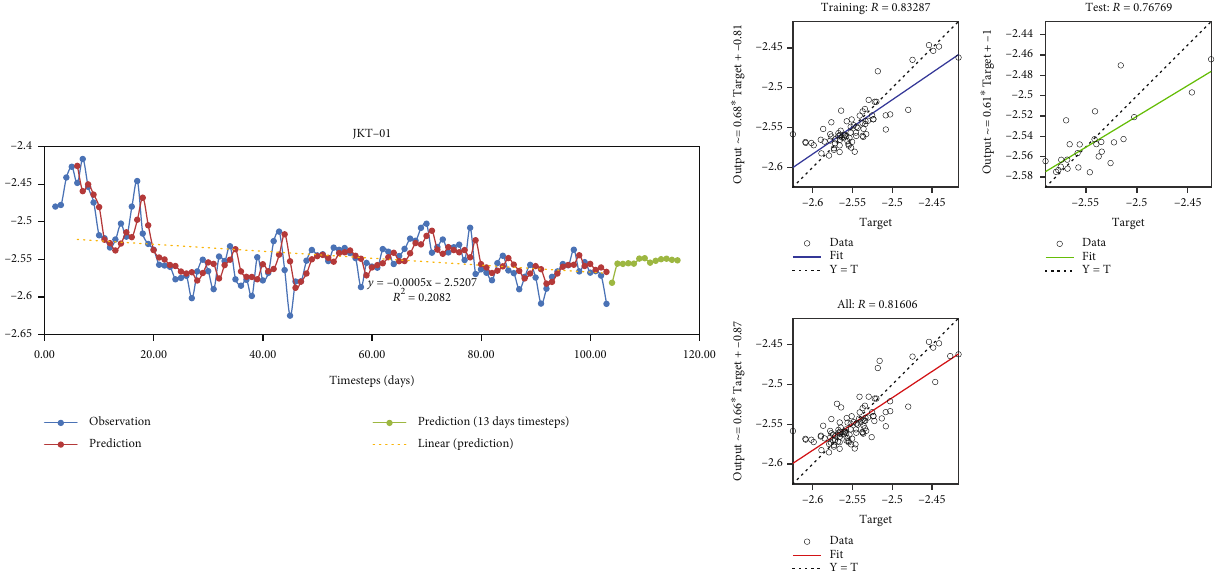
Figure 5: NARX prediction and model performance for JKT-01.